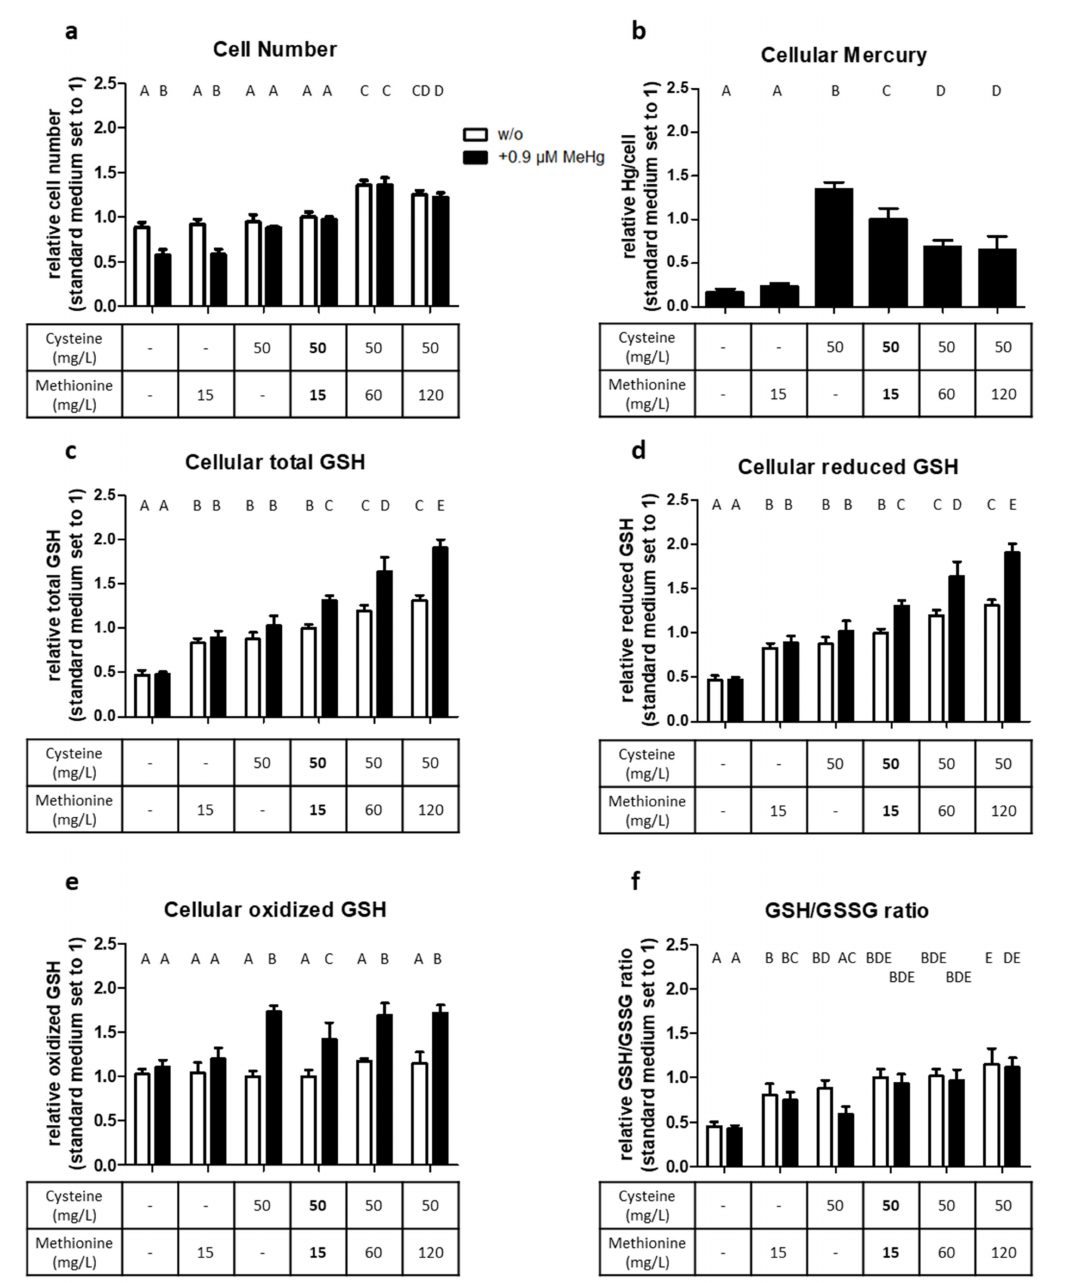
Figure 5. Effect of cysteine and methionine on cell number, Hg levels, and GSH status of HTR-8/SVneo cells. Cells were cultured for 24 h in media with different amino acid levels of cysteine and methionine (the standard medium containing 50 mg/L cysteine and 15 mg/L methionine are in bold numbers), either in the presence of 0.9 µ M MeHg or without MeHg (w/o). In addition to cell number ( a ) and cellular Hg levels ( b ), cellular total GSH, reduced GSH, oxidized and GSH/GSSG ratio ( c–f ) were analyzed as indicators for oxidative stress. The data represent mean values ± SD from three independent experiments, each performed in triplicate. Letters A–E denote homogeneous subgroups derived from one-way ANOVA and S–N–K post hoc test ( p <